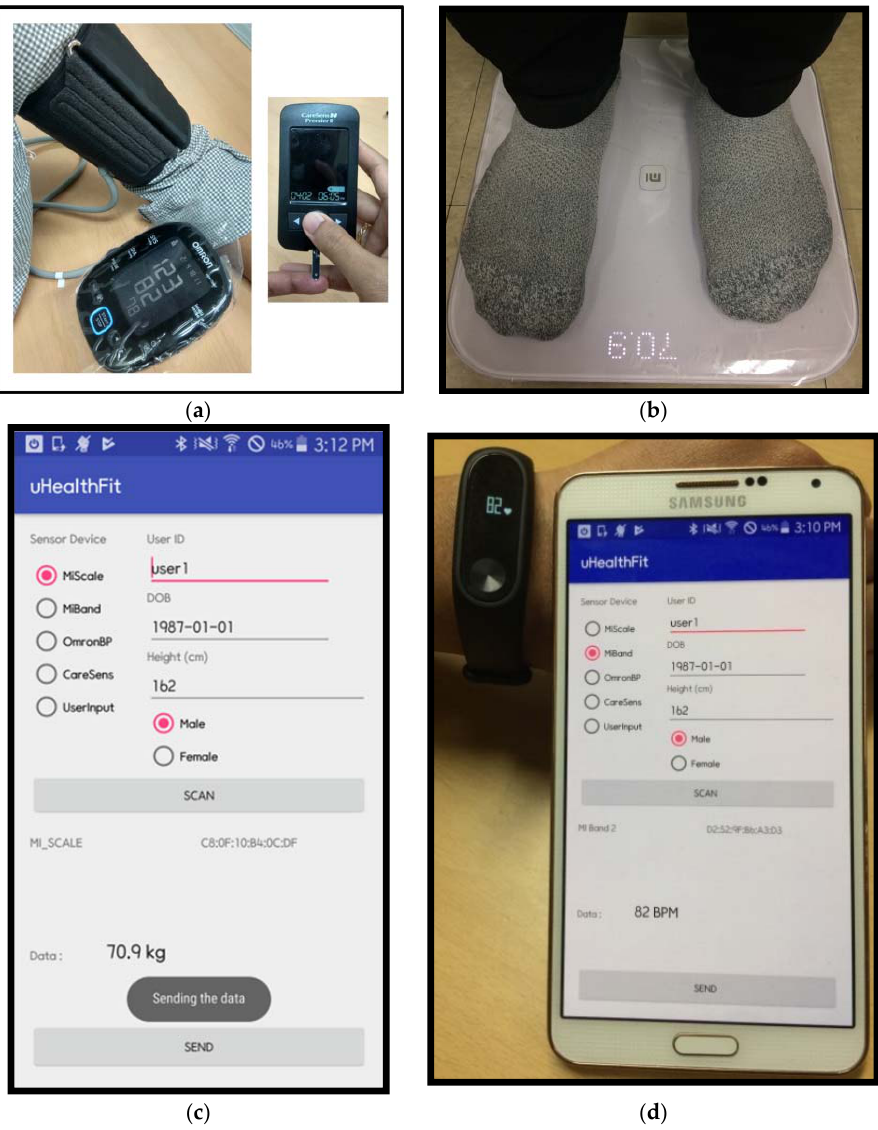
Figure 5. ( a ) The blood pressure and blood glucometer devices; ( b ) weight measurement by a user; ( c ) weight data presented in real ‐ time by the android app; and ( d ) the heart rate sensor in operation.